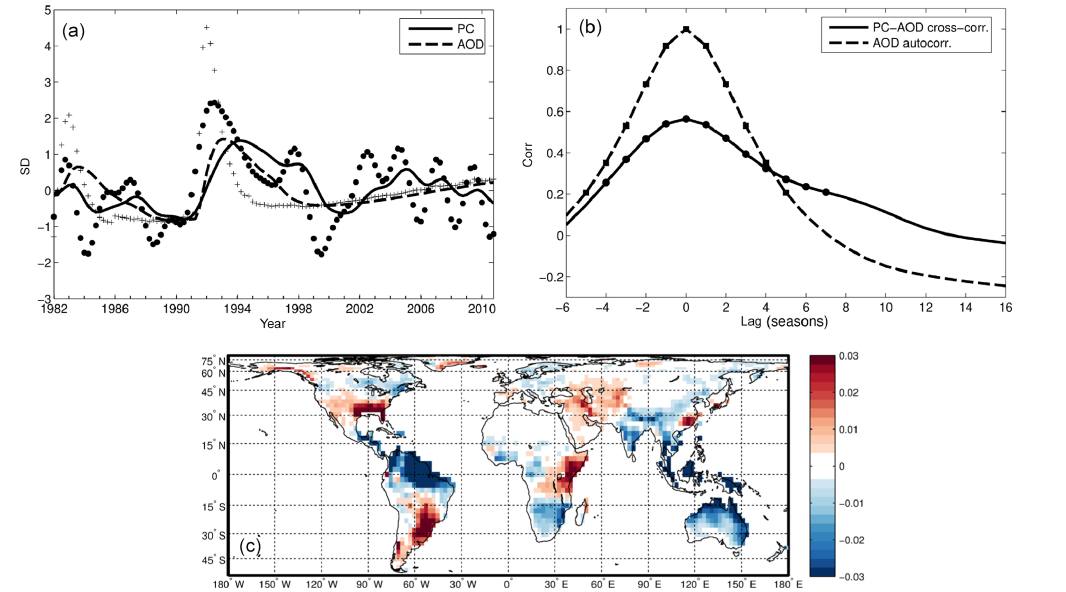
Figure 3. (a) First normalized PC of the PRE anomalies forced by the SM (full line and filled circles), after cutoff low-pass filtering at 2 year − 1 frequency. Dashed line (and cross marks) stands for the normalized stratospheric aerosol optical depth (AOD). Lines stand for 5-year exponential moving average, while marks represent each single season. (b) Lagged correlations between AOD and PC1 of the forced PRE. The dashed curve is the autocorrelation function of the AOD. Marks indicate significance at the 5% level. (c) First EOF of the forced PRE. Arbitrary